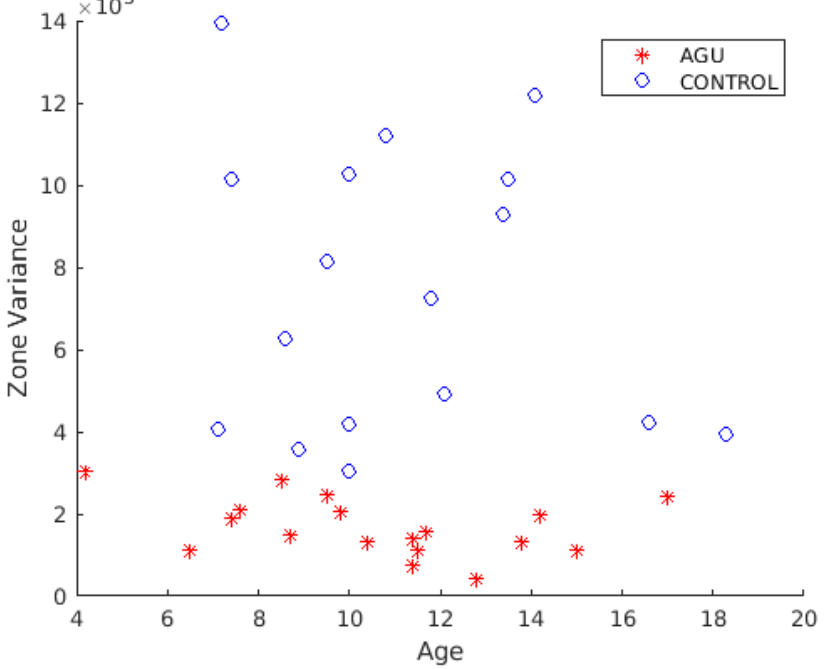
Figure 6. Subjects’ zone variance plotted against the age in years. No correlation with the age of the subject was found in either group at the significance level of 0.05.